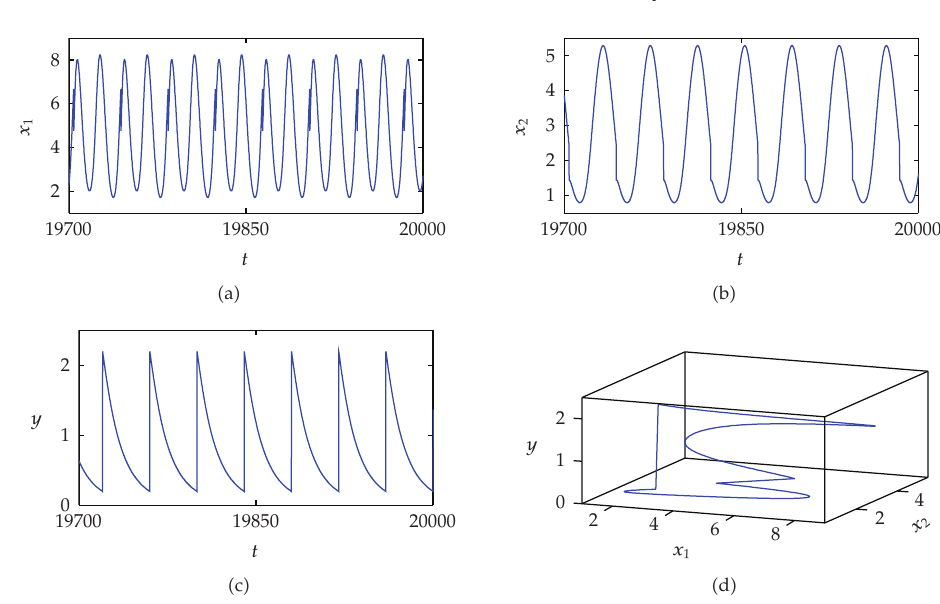
Figure 2: (cid:3) a (cid:4) – (cid:3) c (cid:4) Time series. (cid:3) d (cid:4) The trajectory of system (cid:3) 1.2 (cid:4) with an initial value (cid:3) 2 , 3 , 1 (cid:4)